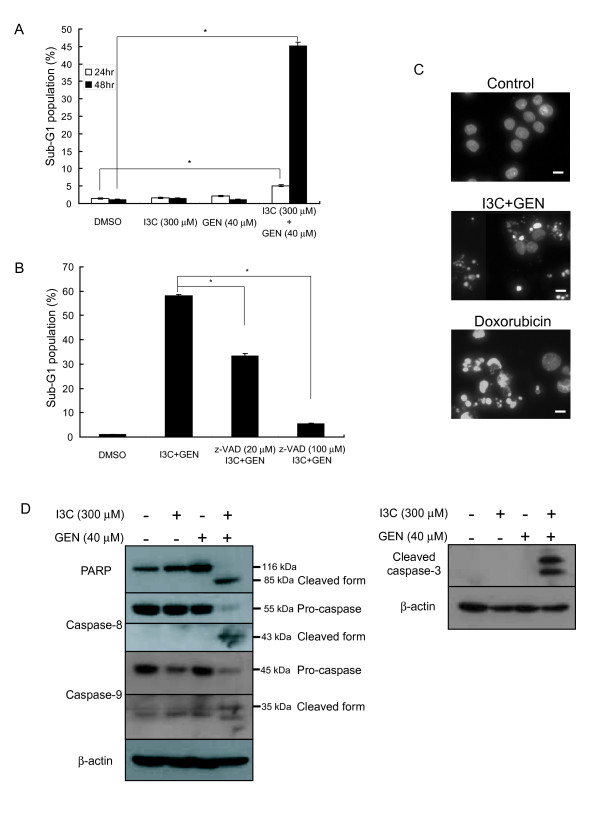
Effects of co-treatment with I3C and genistein on apoptosis in HT-29 cells. A, The sub-G1 population was assessed by flow cytometry as described in Materials and Methods after exposure to the indicated agents for 24 or 48 h. Columns, mean (n = 3); bars, SD. *, P < 0.05, significantly different compared with the DMSO-treated control. B, HT-29 cells were exposed to DMSO or a combination of I3C (300 μmol/L) and genistein (40 μmol/L) for 48 h or pretreated with z-VAD-fmk (20 or 100 μmol/L) for 2 h followed by exposure to the combination for 48 h. The sub-G1 population was quantified by flow cytometry as described in Materials and Methods. Columns, mean (n = 3); bars, SD. *, P < 0.05, significantly different compared with the combined treatment. C, Cells were exposed to DMSO (control), a combination of I3C (300 μmol/L) and genistein (40 μmol/L), or doxorubicin (1 μmol/L) for 48 h, stained with DAPI, and observed under a fluorescence microscope as described in Materials and Methods. Doxorubicin was used as a positive control to induce apoptosis. Bars, 20 μm. D, HT-29 cells were exposed to the indicated agents for 48 h. The expression of PARP, caspase-8, caspase-9 and cleaved caspase-3 proteins was analyzed by western blotting. β-actin was used as a loading control. -, treated with DMSO. GEN, genistein.